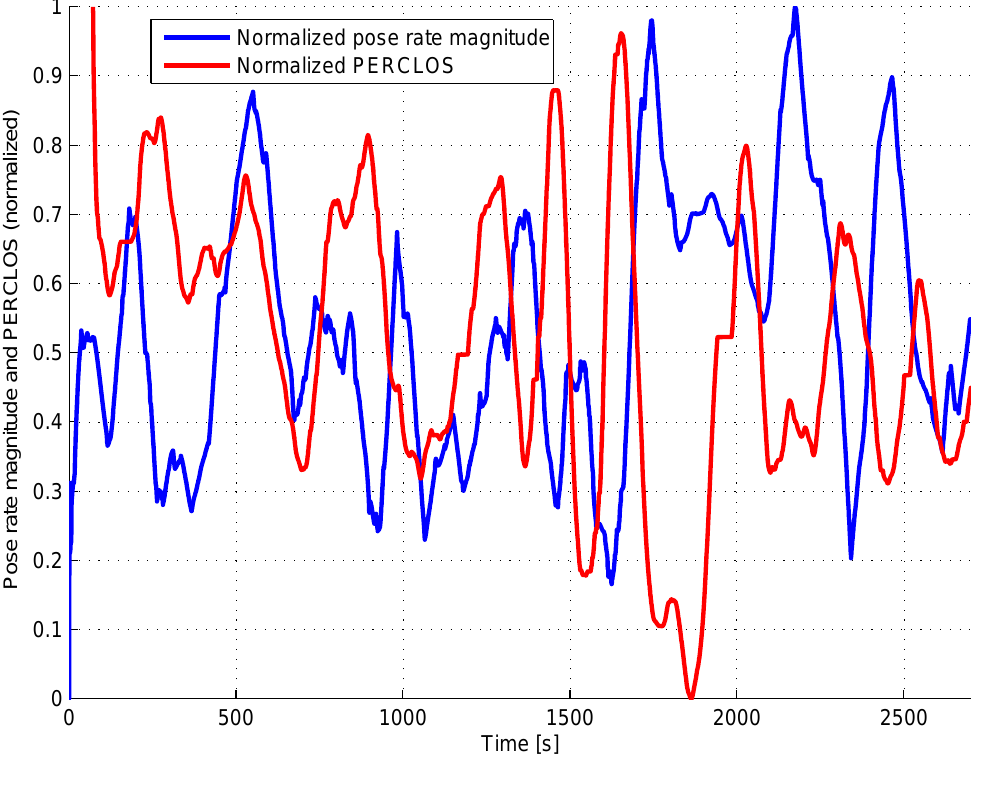
Figure 14. Normalized pose rate magnitude and normalized PERCLOS measure for drowsy subject 11, both smoothed with a moving average filter using a window of 80 seconds.